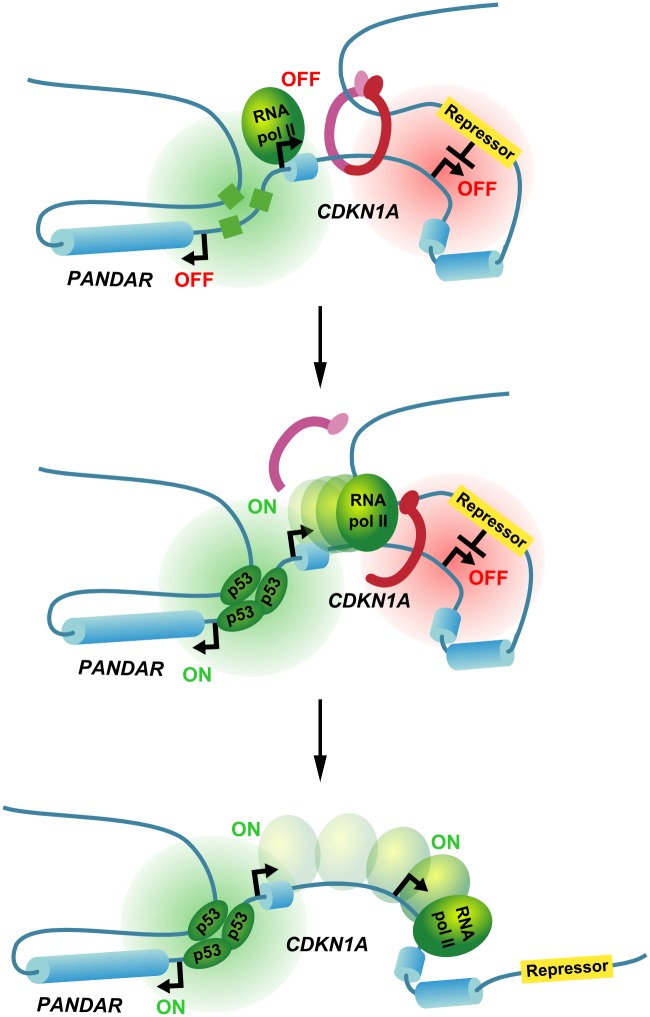
Model of the CDKN1A chromatin loop molecular switch.Following activation of CDKN1A by p53 in response to stress, the passage of the transcriptional machinery evicts the cohesin and disrupts the chromatin loop. This releases the internal promoter from the influence of the repressor element and results in the induction of p21C.